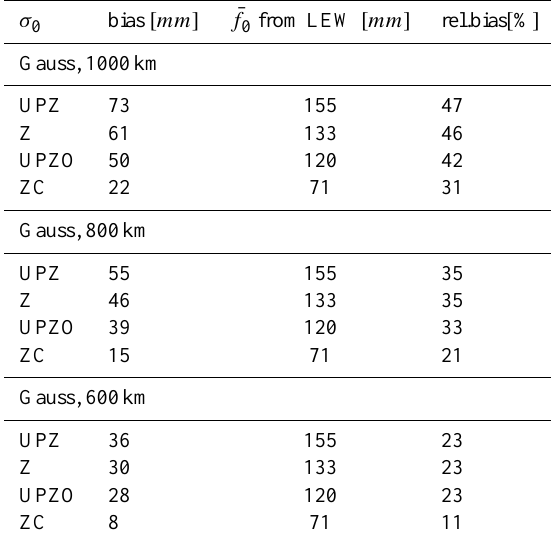
Table 1. Amplitudes of the annual bias for different target areas, computed from LEW model output. Annual amplitudes of (un- filtered) LEW water storage variations and bias-to-signal-ratio are given for comparison.